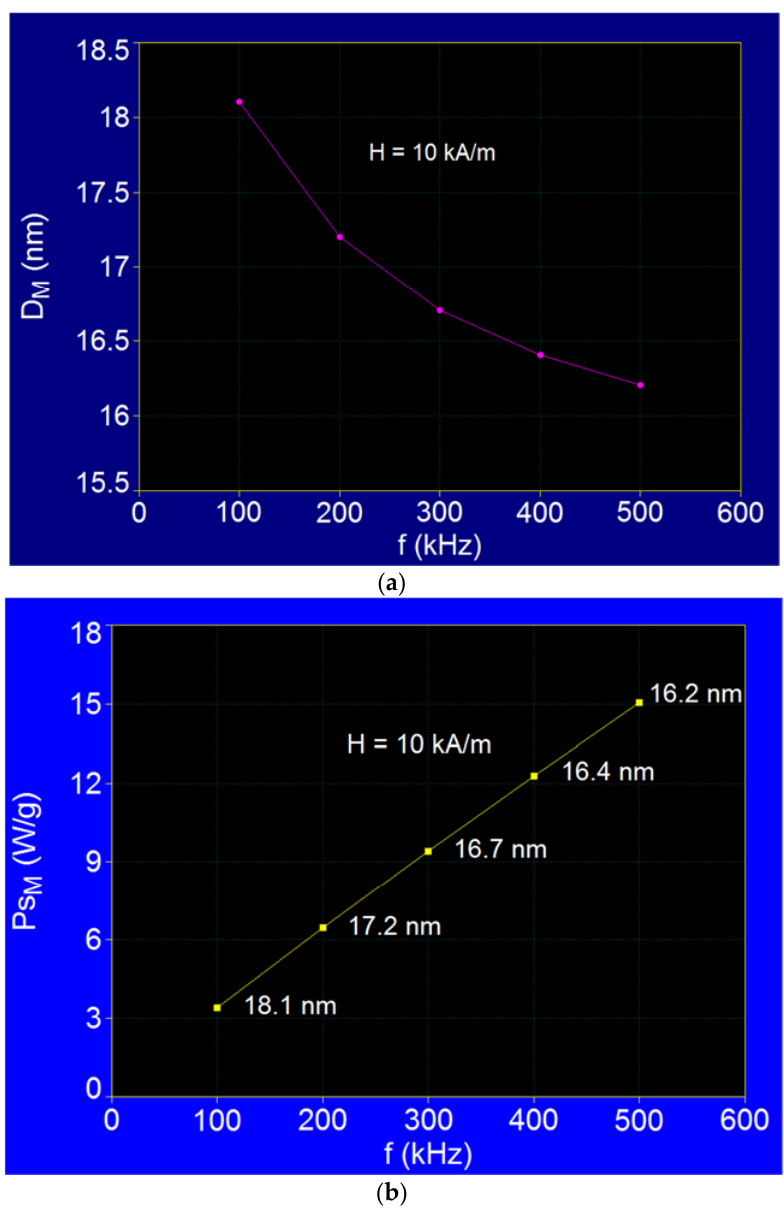
Figure 9. The variations of ( a ) D M and ( b ) P sM as a function of magnetic field frequency for dispersed Fe 3 O 4 - γ -CDs bionanoparticles.